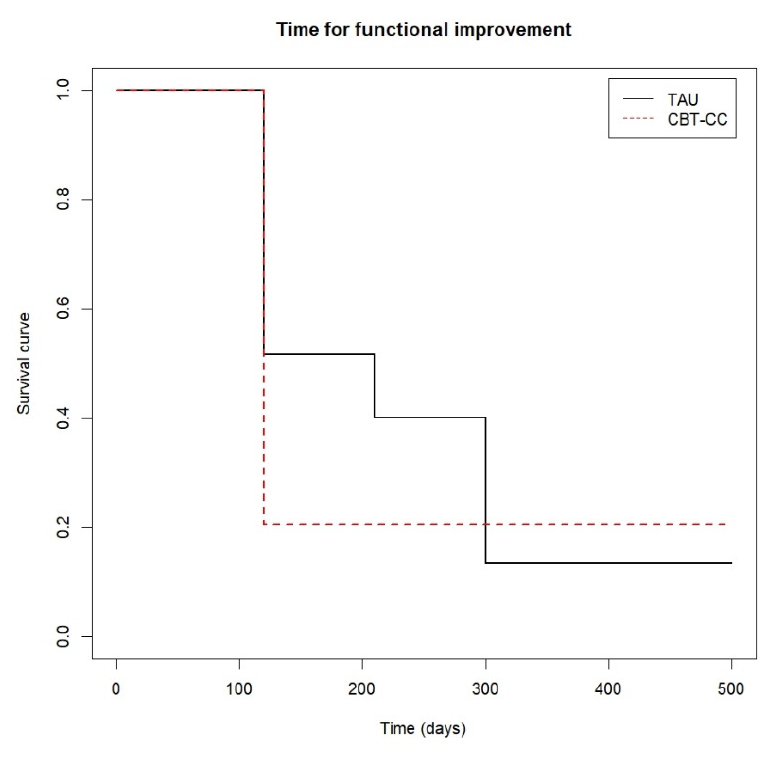
Figure 6. Time to functional